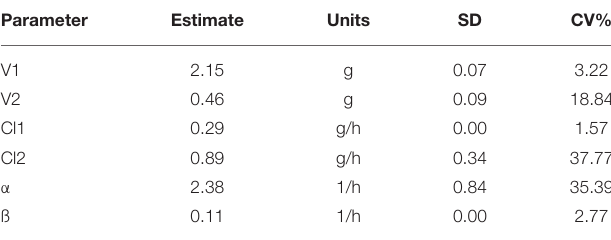
TABLE 4 | Population pharmacokinetic parameters of rifaximin in mammary gland using the NONMEM model. Parameter